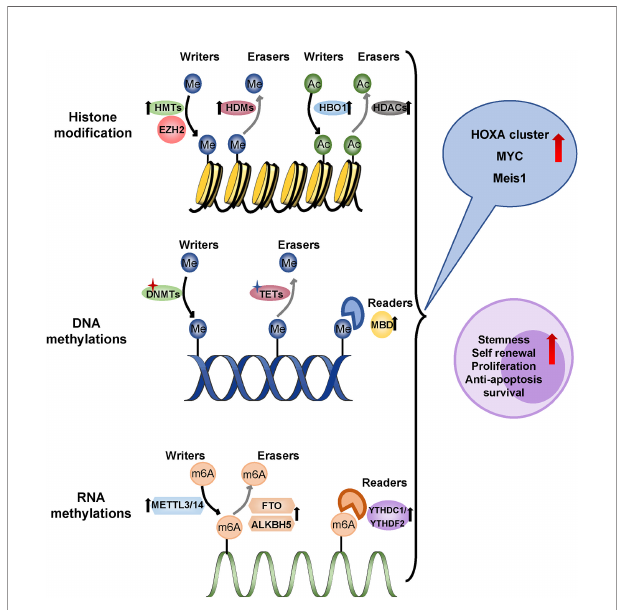
FIGURE 6 | Epigenetic regulation in LSCs. Methylation operates at the DNA, RNA, and histone levels as a ‘ reader ’ , ‘ writer ’ and ‘ eraser ’ . LSCs showed a hypomethylated state which overexpressed the tumor-promoting gene like HOXA cluster, MYC and MEIS1. Overexpressed HBO1 in LSCs adds acetyl to histone H3K14 up-regulating HOXA gene transcription. Me, methyl; Ac, Acetyl; HMTs, histone methyltransferases; HDMs, histone demethylases; EZH2, zeste homolog 2; HBO1, lysine acetyltransferase 7; HDACs, histone deacetylases; DNMTs, DNA methyltransferases; TETs, ten-eleven translocation; MBD, methyl-CpG binding domain protein 2; m6A, N6- methyladenosine; METTL3/14, methyltransferase-like protein 3/14; FTO, fat mass and obesity-associated protein; ALBH5, ALKB Homolog 5YTHDC1/ YTHDF2, YTH family